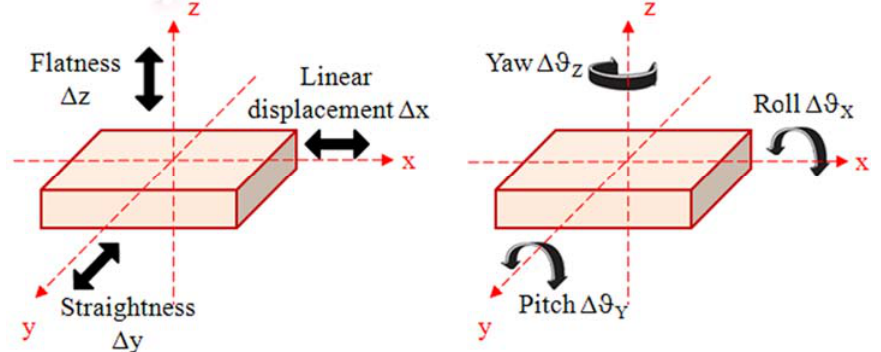
Figure 1. Coordinate system convention, linear (at the left) and angular (at the